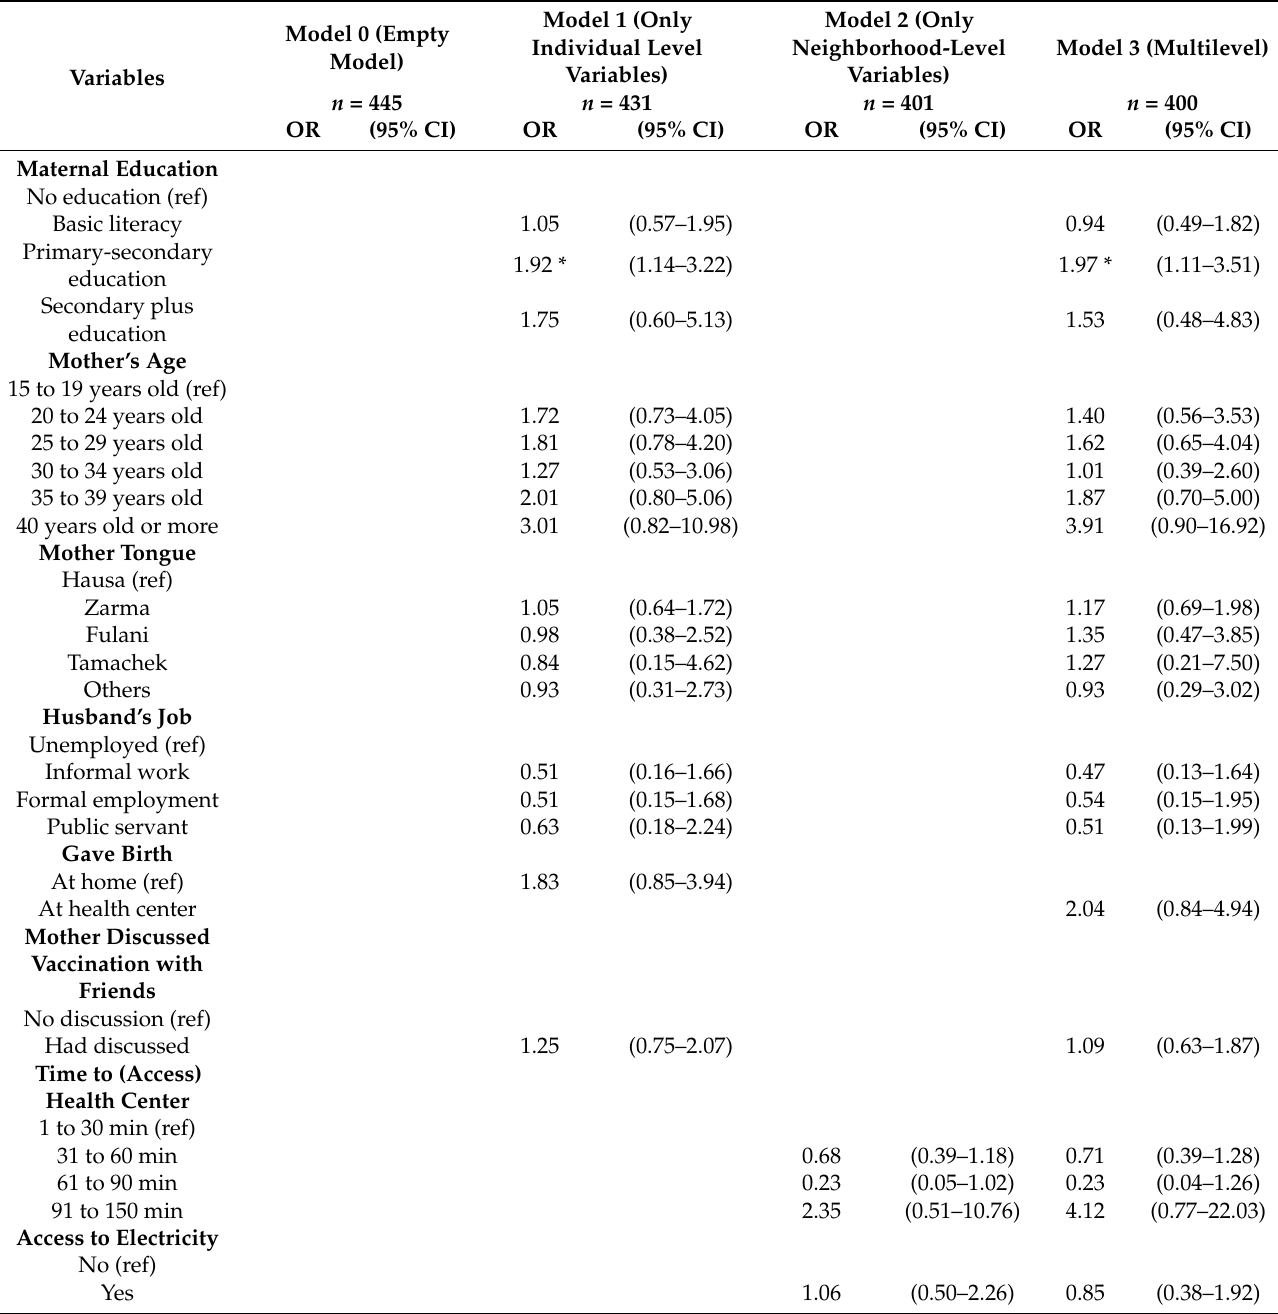
Table 2. Factors of measles 1 vaccination from multilevel logistic regression